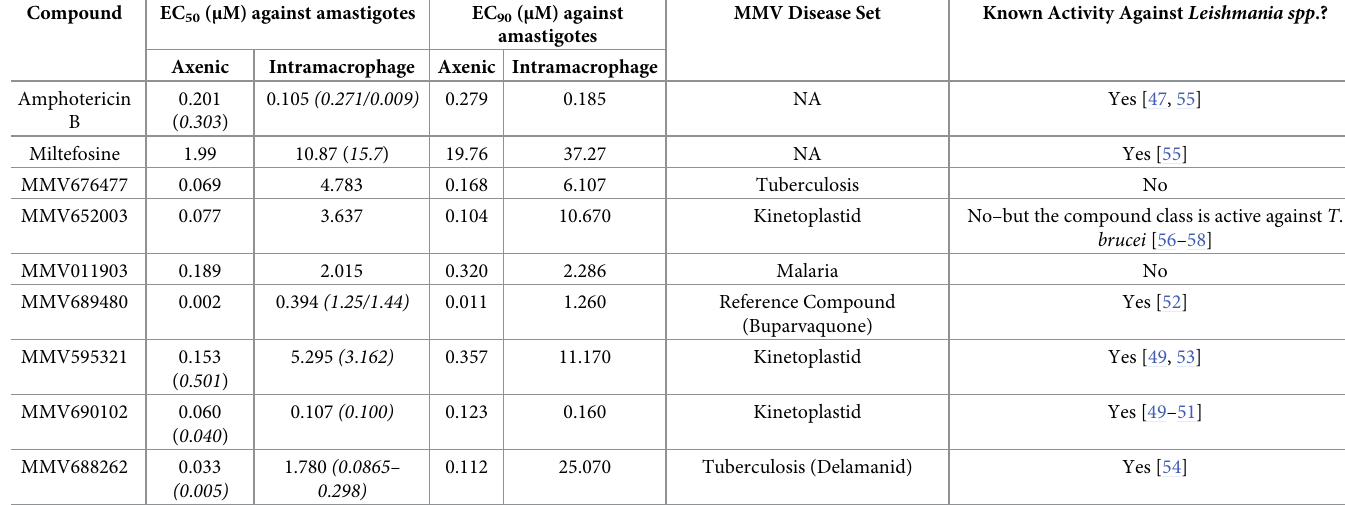
Table 2. Activity of the six most potent MMV compounds against axenic and intramacrophage amastigotes. Previous EC 50 data for compounds against Leishmania spp . are shown in italics, where